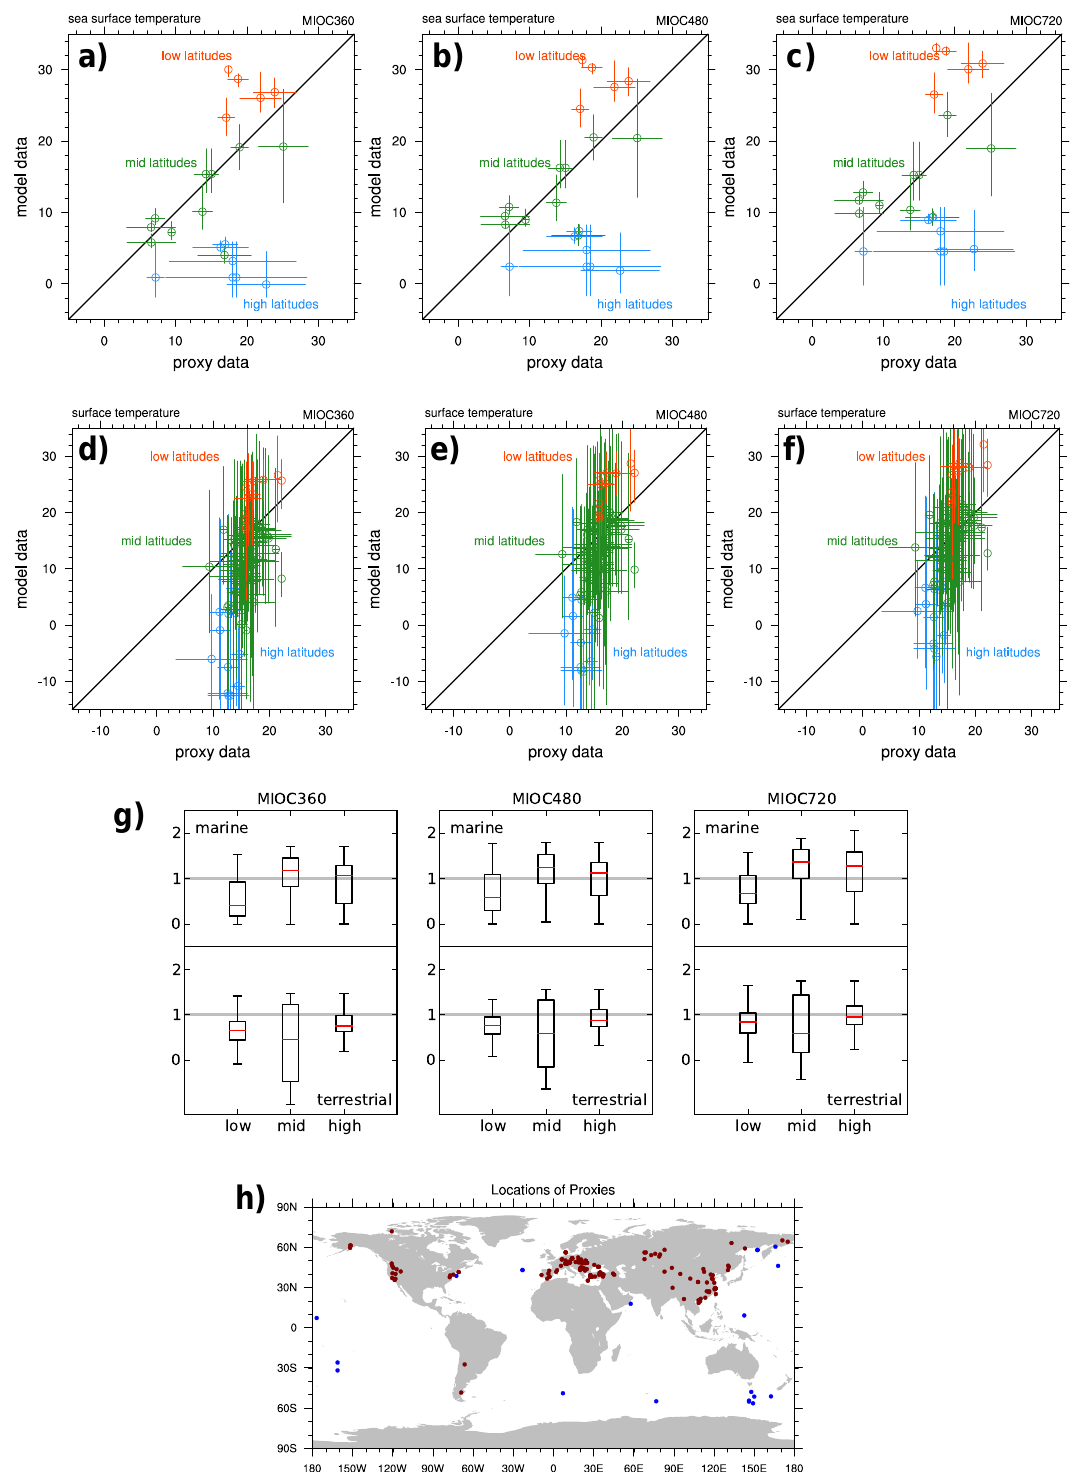
Fig. 14. Comparison of model output with (a) – (c) terrestrial and (d) – (f) marine temperature reconstructions. The low latitudes are defined to be between the equator and 30 ◦ N/S, midlatitudes are between 30 and 55 ◦ N/S, and high latitudes are poleward of 55 ◦ N/S. (g) Box plot of model-to-data temperature ratios for each grid box, separated for marine and terrestrial proxies as well as for low, mid-, and high latitudes. Values near 1 correspond to a good agreement, while values greater (smaller) than 1 show that the model is too warm (cold). The red line corresponds to the mean of the distribution. (h) The location of the